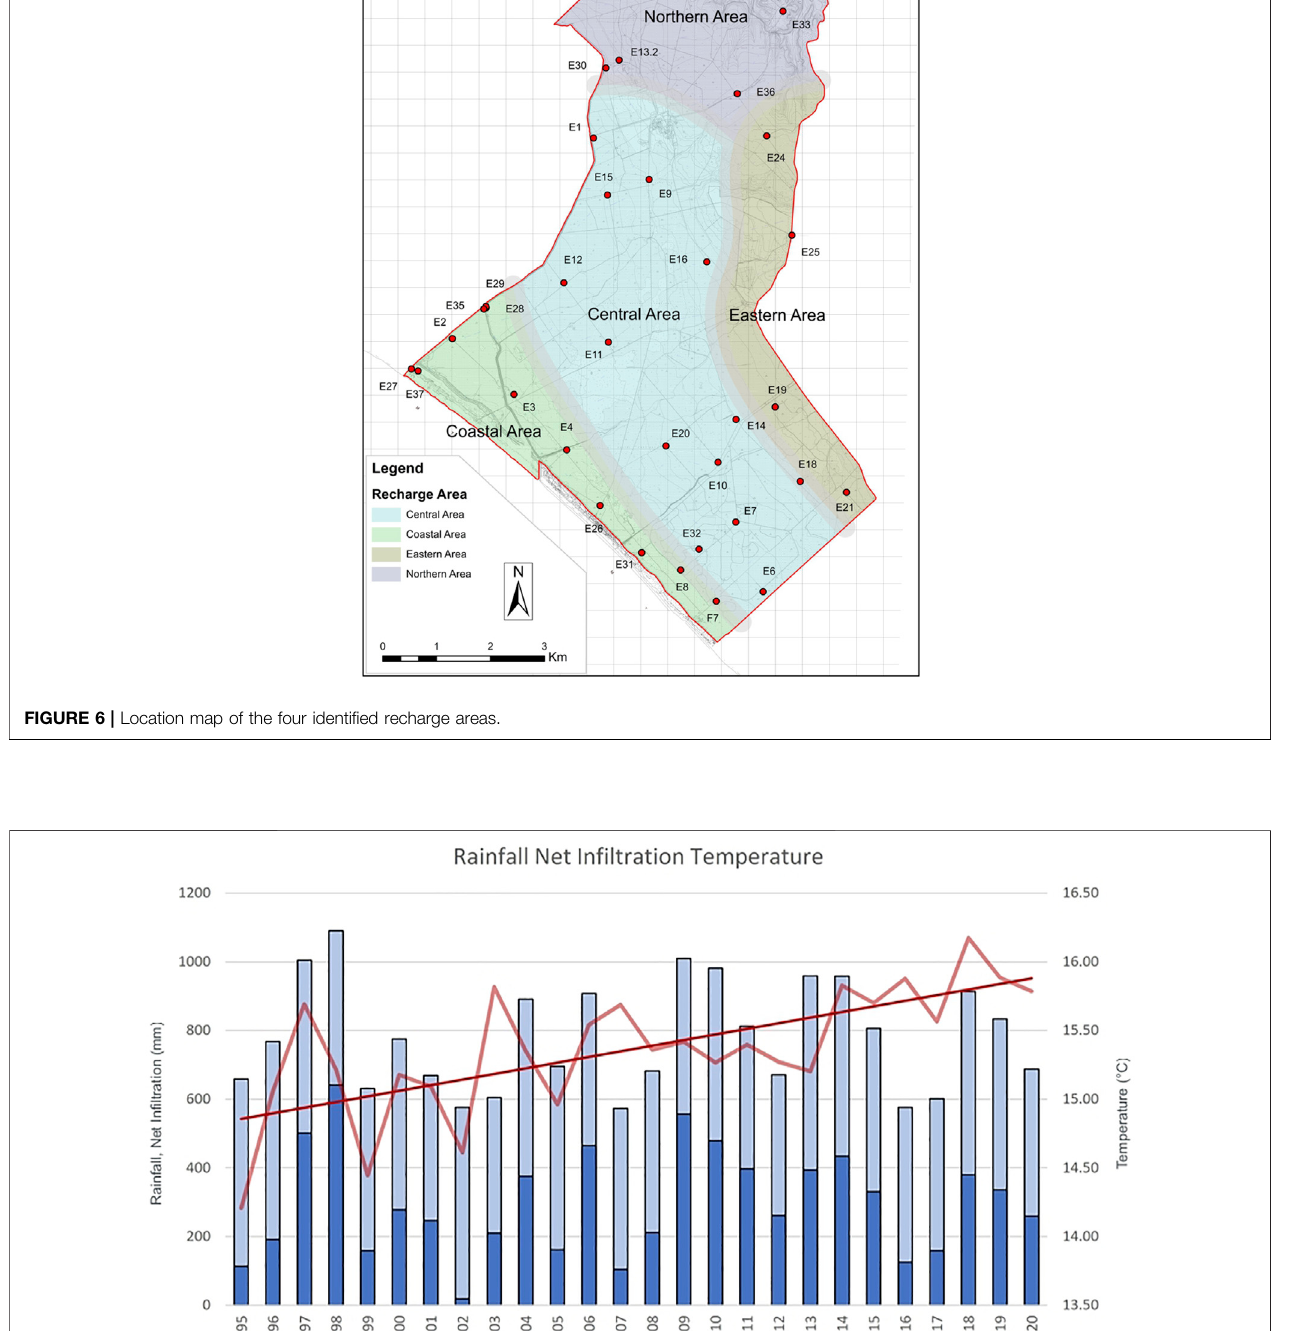
Frontiers in Earth Science |